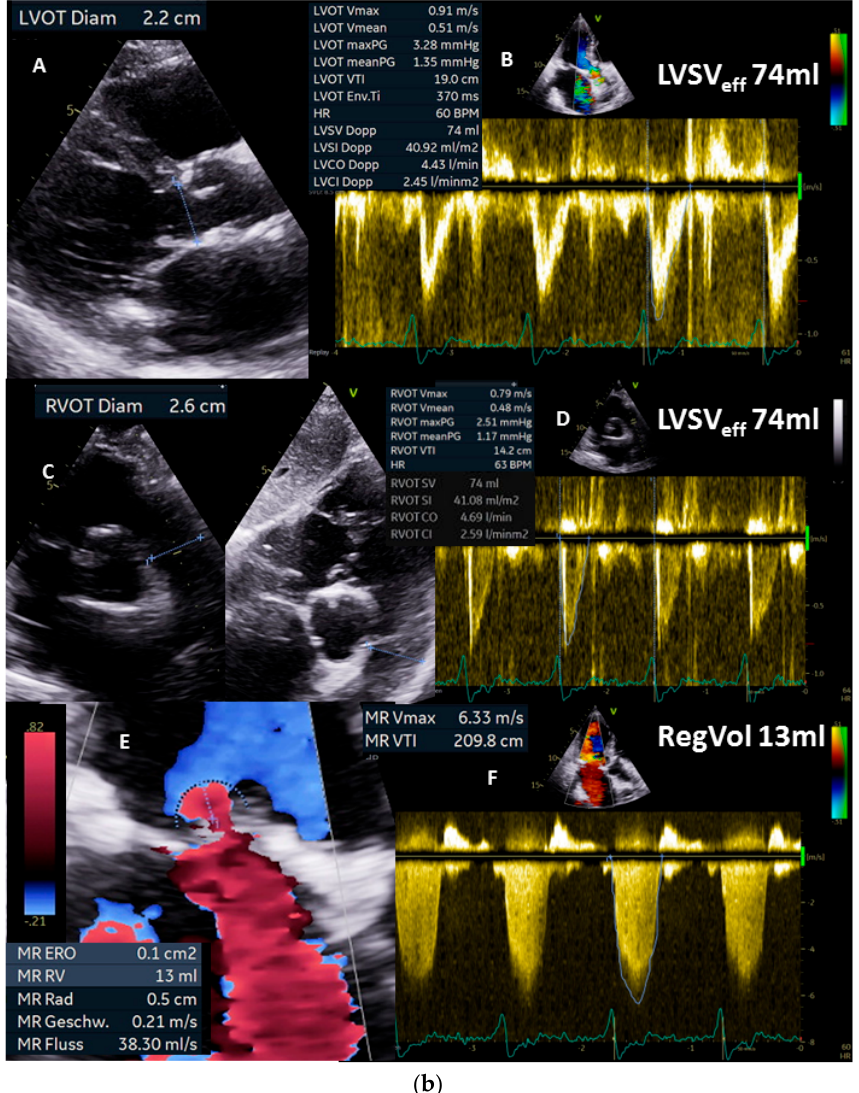
Figure 4. ( a ): Illustration of a systolic regurgitant jet phenomenon in a patient with isolated mitral regurgitation and the quantitative analysis of left ventricular volume parameters. In ( A ), the small vena contracta < 1 mm despite a remarkable jet area is shown. In ( B ), monoplane LV planimetry is shown using the apical long-axis view. In ( C ), the biplane LV planimetry is shown documenting a total LVSV of 90 mL. In ( D ), a color-coded M-Mode through the MR shows a nearly constant PISA radius. In ( E ), the cw regurgitant Doppler velocity is shown. LVEDV = left ventricular end diastolic volume, LVESV = left ventricular end systolic volume, LVSV = left ventricular stroke volume, LVSV tot = total LVSV, and LVEF = left ventricular ejection fraction. ( b ): Illustration to assess quanti- tatively effective LVSV and RVSV by pw Doppler echocardiography as well as regurgitant volume by 2D PISA method to analyze severity of mitral regurgitation (MR): in ( A ), the parasternal long- axis to document LVOT diameter during systole is shown; in ( B ), the measurements of LVSV eff by pw Doppler spectrum at the level of the LVOT is shown; in ( C ), the parasternal and subcostal short- axis views are shown to document RVOT diameter during systole; in ( D ), the measurements of RVSV eff by pw Doppler spectrum at the level of the RVOT is shown. The estimation of RegVol MR by 2D PISA is demonstrated by delineation of the 2D-PISA radius and the velocity time integral of the retrograde transmitral velocity during systole ( E , F ). LVSV = left ventricular stroke volume, LVEF = left ventricular ejection fraction, LVSV eff = effective LVSV, RegVol = transmitral regurgitant volume, LVOT = left ventricular outflow tract, RVOT = right ventricular outflow tract.